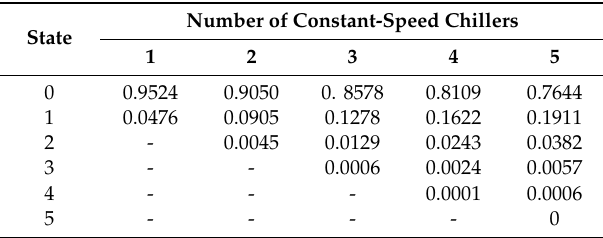
Table 3. Probability distribution of steady states of constant-speed chillers.